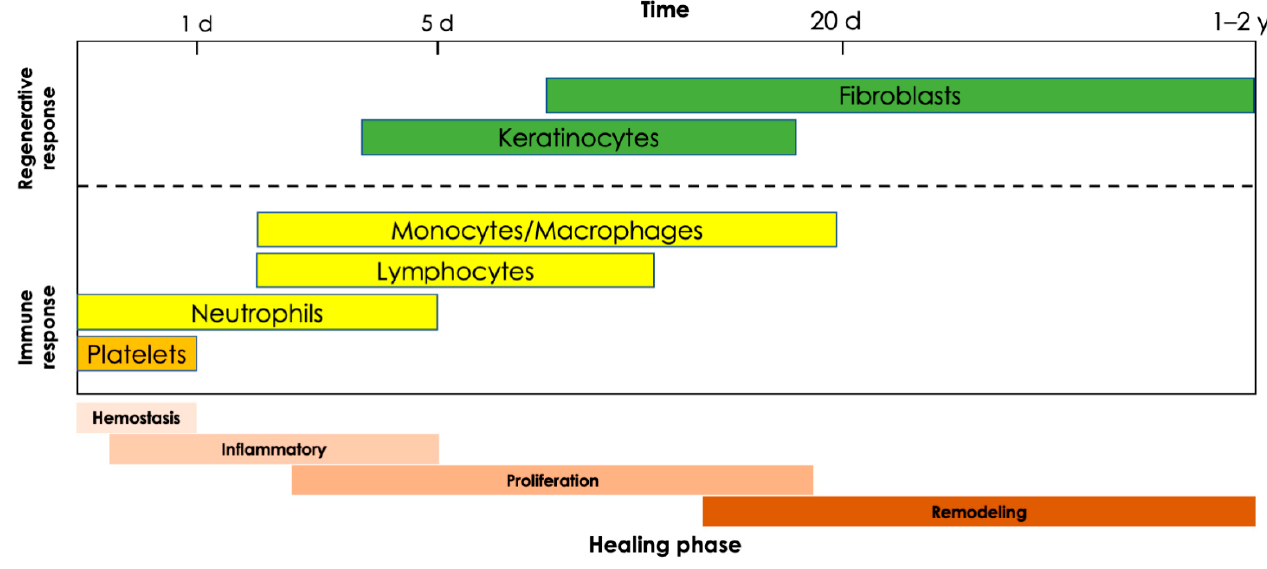
Figure 2. Summary of the main immune and regenerative cells involved in burn wound healing at different stages of healing. Abbreviations: d, day; yr, year.